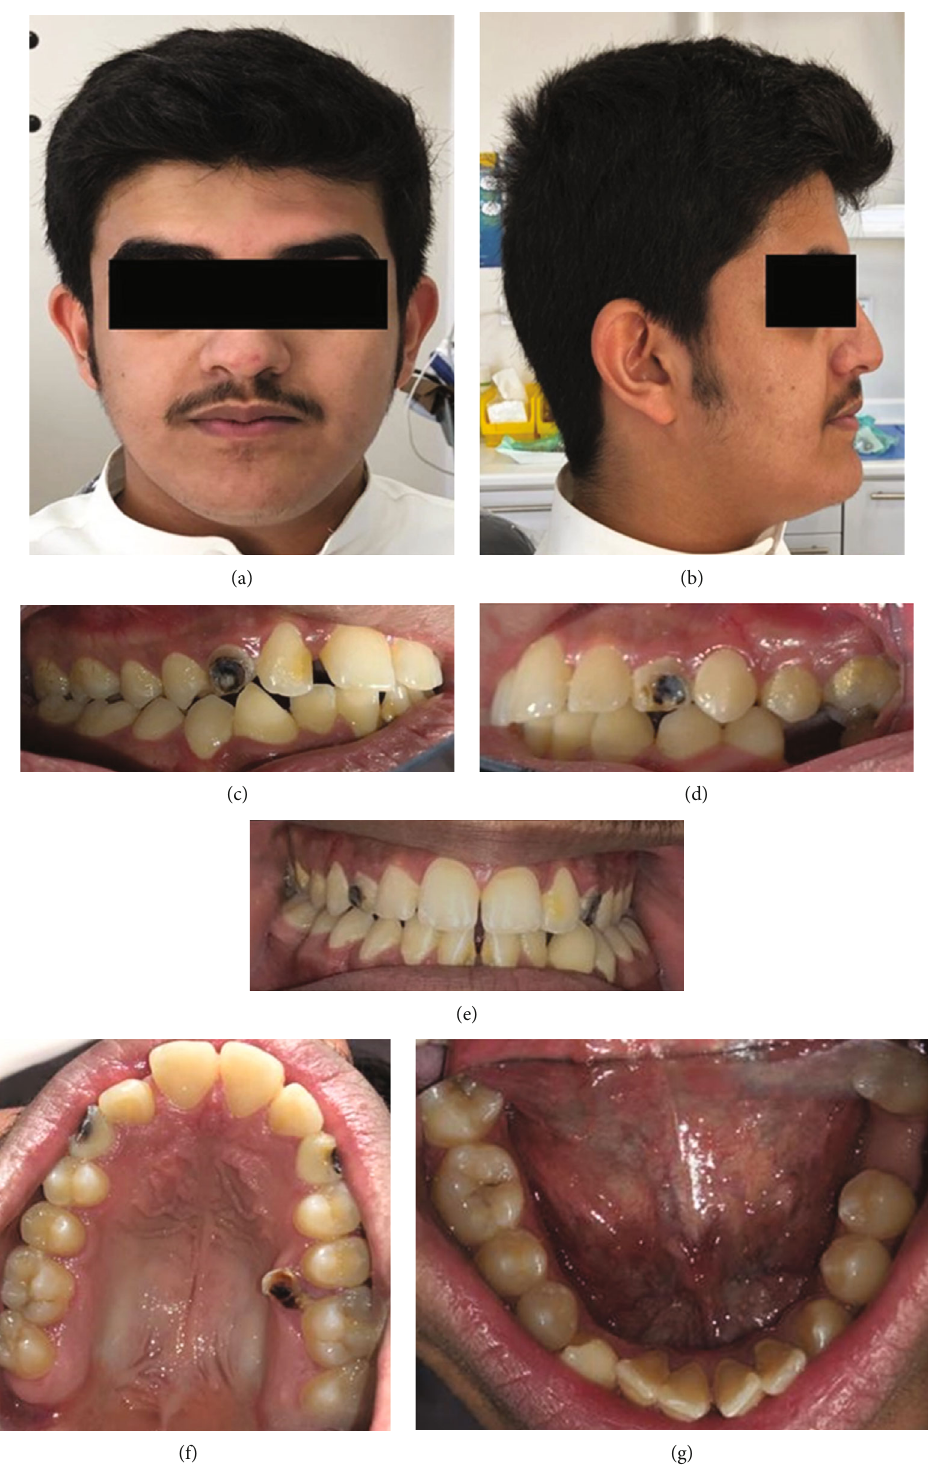
Figure 1: A clinical frontal view of the patient ’ s face and neck (a), lateral pro fi le view (b), intraoral lateral view of the patient ’ s left side (c), IO right side (d), IO frontal view (e), IO upper occlusal view (f), and IO lower occlusal view